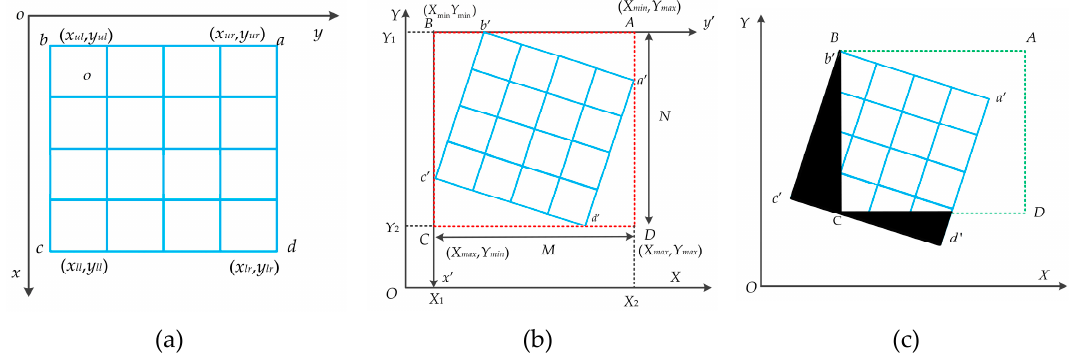
Figure 1. The georeferenced image size. ( a ) Input image. ( b ) Output image. ( c ) Incorrect output image. ur :, upper right; ul :, upper left; ll :, lower left; lr :, lower right. abcd is the input image. ABCD